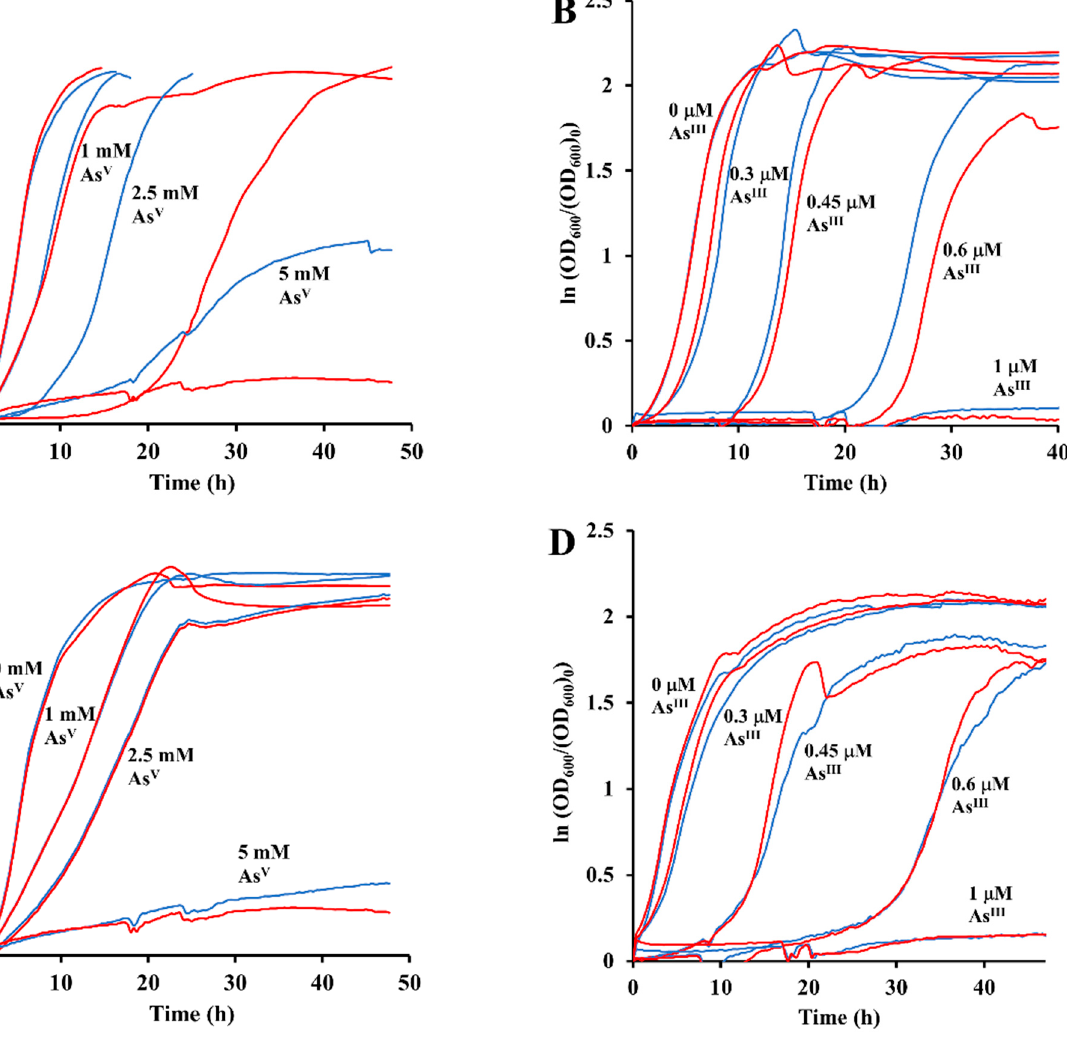
Figure 7. The averaged ( n = 3) growth curves of E. coli BL21(DE3)pLys harboring the arsH gene (panels ( A , B )) and the negative control lacking it (panels ( C , D )) cultured in M9 medium with glucose with the addition of the indicated concentration of PhAsO(OH) 2 (panels ( A , C )) or PhAsO (panels ( B , D )). Blue curves and red curves have been obtained in the absence and in the presence of 1 mM IPTG, respectively.